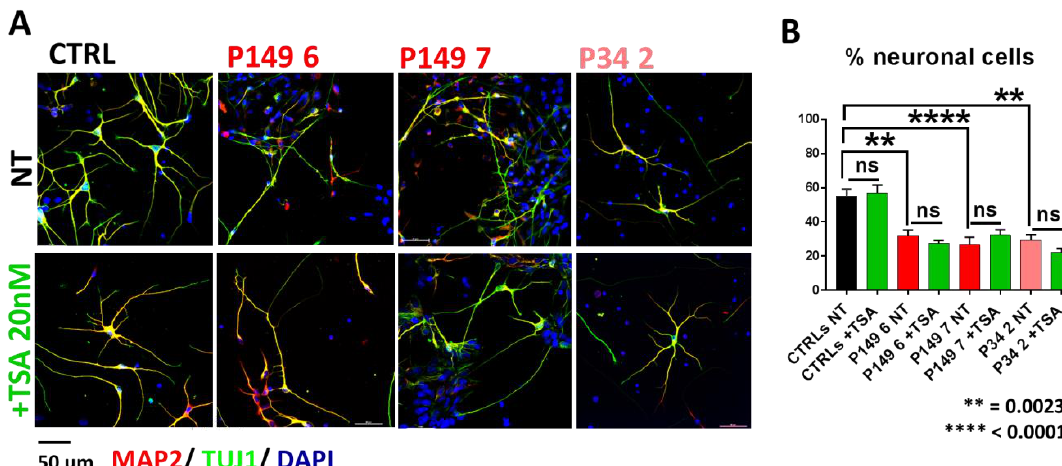
Figure 2. Percentage of neuronal cells in controls, P149 6 and 7, and P34 2 neural progenitor cell lines cultured for one week in neural differentiation medium without (top panels) and with (bottom panels) TSA 20 nM. ( A ) Immunofluorescence of neuronal markers MAP2 (red) and TUJ1 (green). Nuclei are counterstained with DAPI. Scale Bar 50 µ m. Patients lines show, as compared to controls, a higher number of DAPI positive cells unstained by MAP2 and TUJ1 antibodies (top panels) persisting after TSA treatment (bottom panels). ( B ) Graphs showing a highly significant (**** p < 0.0001) and significant (** p = 0.0023) decrease in cells identified as neurons by MAP2/TUJ1 immunostaining in P149 7, and P149 6 and P34 2, respectively, as compared to controls. TSA treatment does not impact the percentage of neuronal cells in both patients and control lines (ns.: not significant) (Kruskal – Wallis non-parametric test).